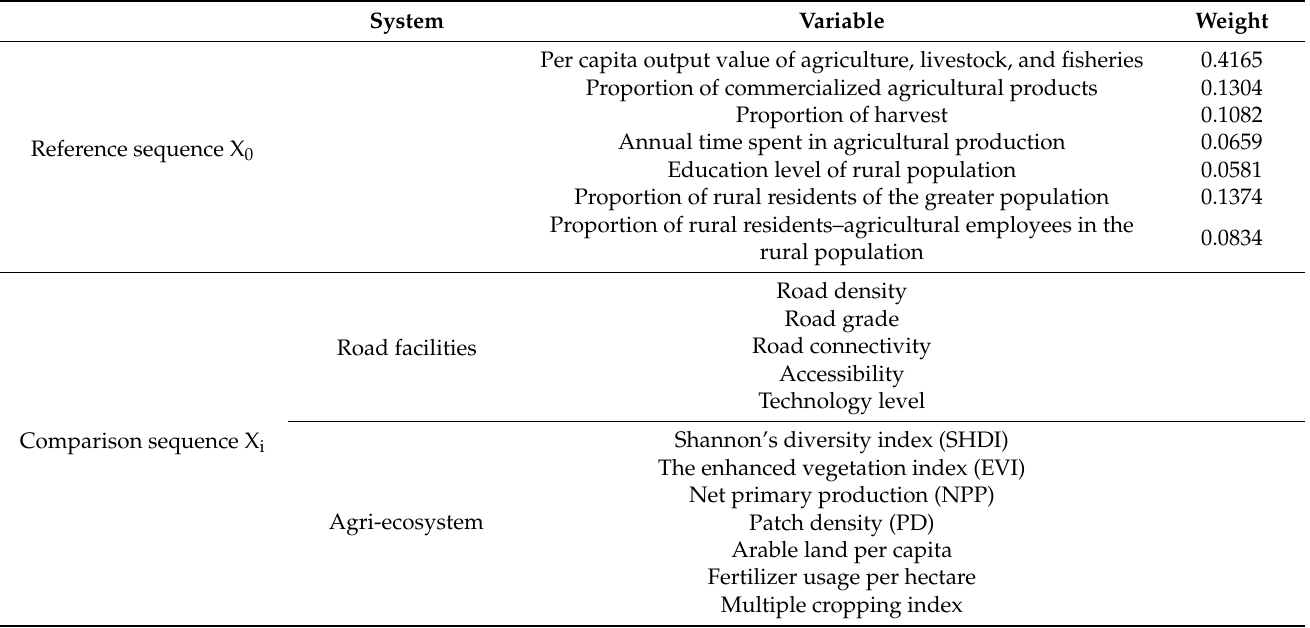
Table 4. Entropy weight grey correlation model variables.